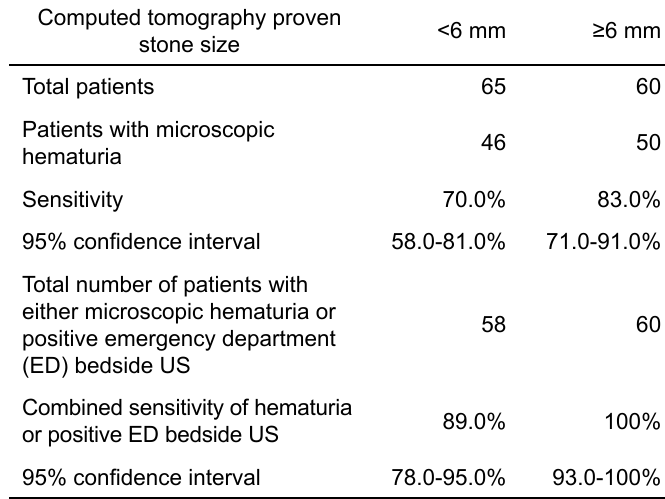
Table 2. Sensitivity of ultrasound (US) in all patients.